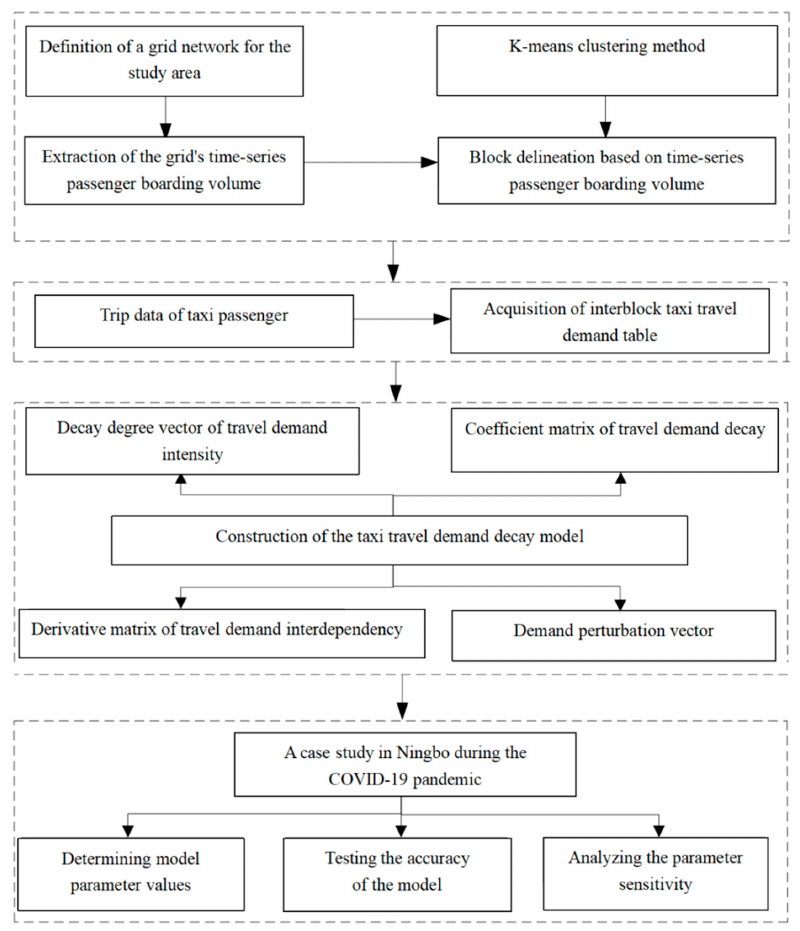
Figure 1. Content of structure framework.